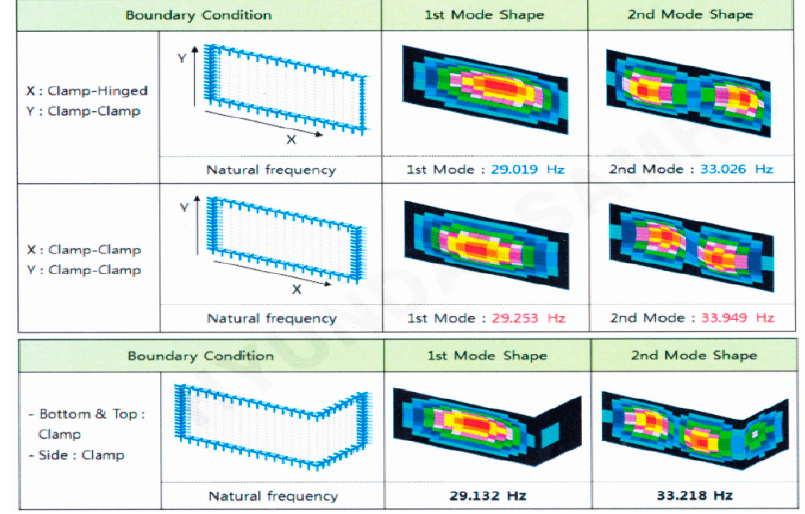
Figure 2. Finite element analysis (FEA) results of single and connected plates.